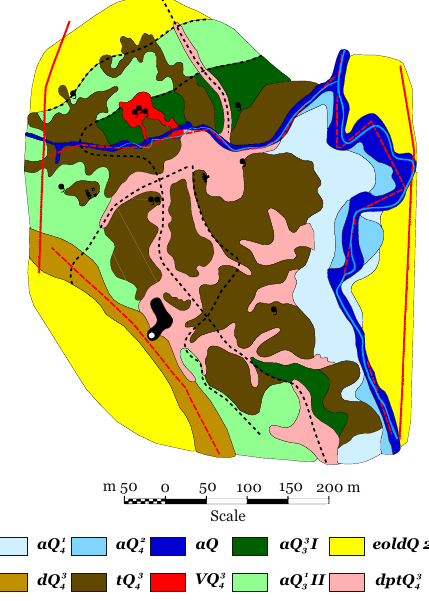
Fig. 1. Geological map of Starunia geodynamic landfill And the Velykyi Lukavets river floodplain is embedded in the body of the 2nd terrace, with a water height of 8–10 m, and an alluvial capacity of up to 5 m. Its sediments of the aQ33I Dauphin-Black Sea horizon [4] are represented by sands, gravel, loam and peat. In total in the thickness of pebble alluvium, ac- cording to the data of drilling, up to 3 lenticular packs of nails are accrued. The lower bundle is associated with the findings of fossil Pleistocene fauna of 4 hairy rhinos and one mammoth, embalmed carcasses of which were found in 1907, in the mine No. 4 (mammoth) and in the specially dug in 1929 at 10–15 m from the previous one.